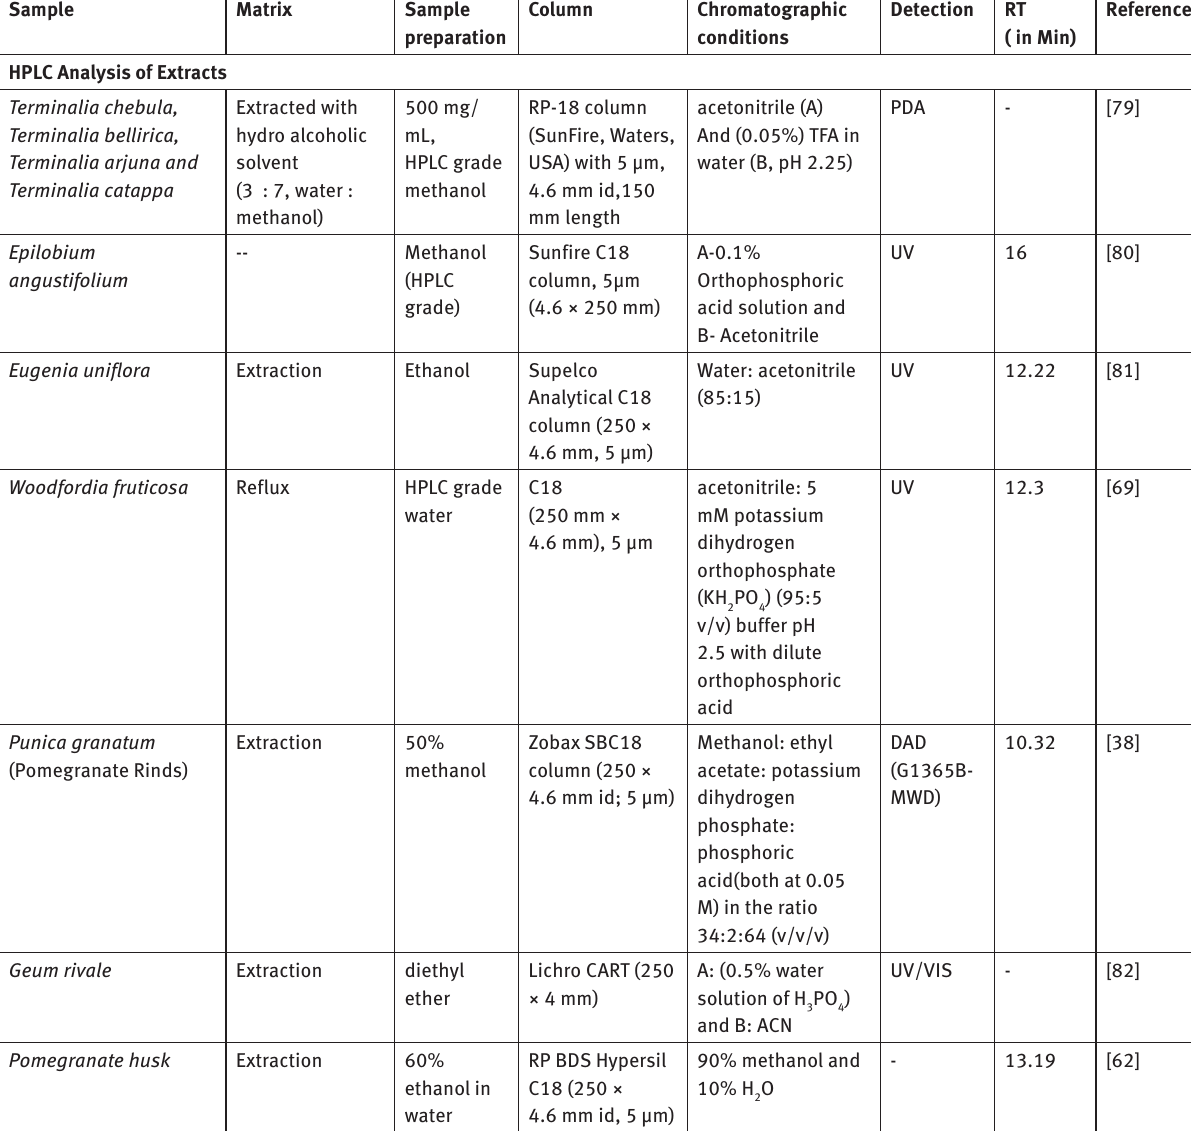
Table 3 Quantitative analysis of ellagic acid by HPLC